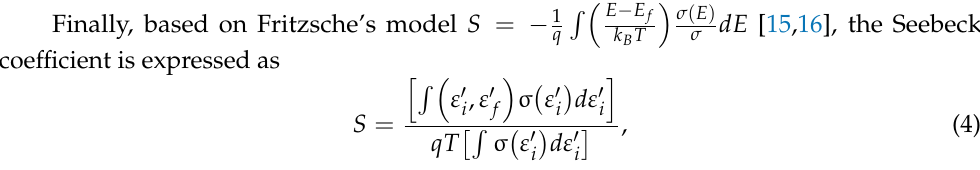
Figure 1. The schematic of carriers’ hopping near the transport energy. The blue region means the possible hopping range of carriers.